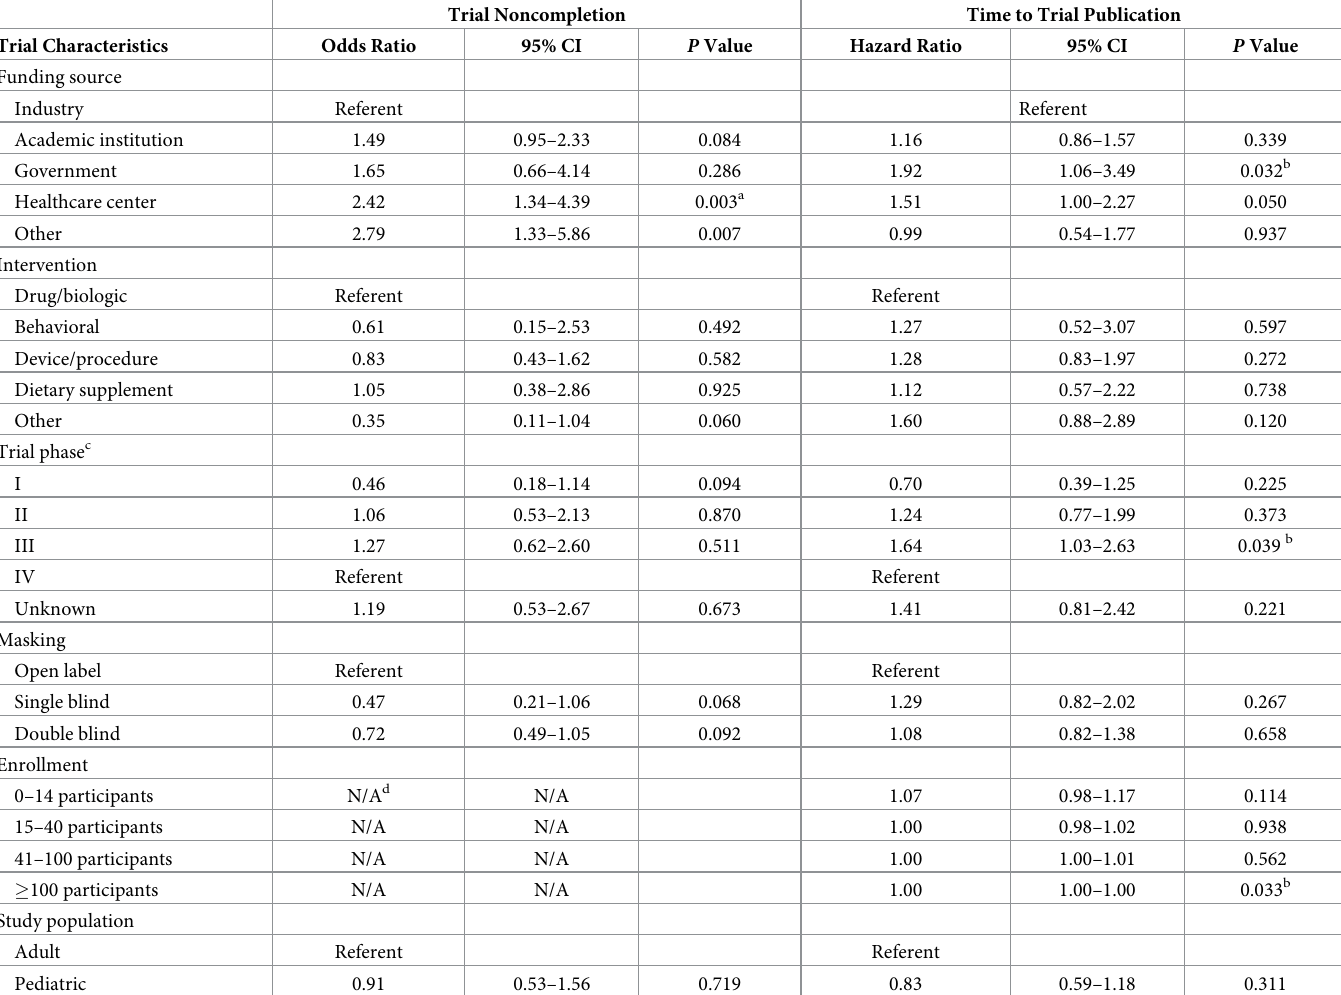
Table 4. Multivariable analysis for impact of funding source on noncompletion and time to publication of trials for rare